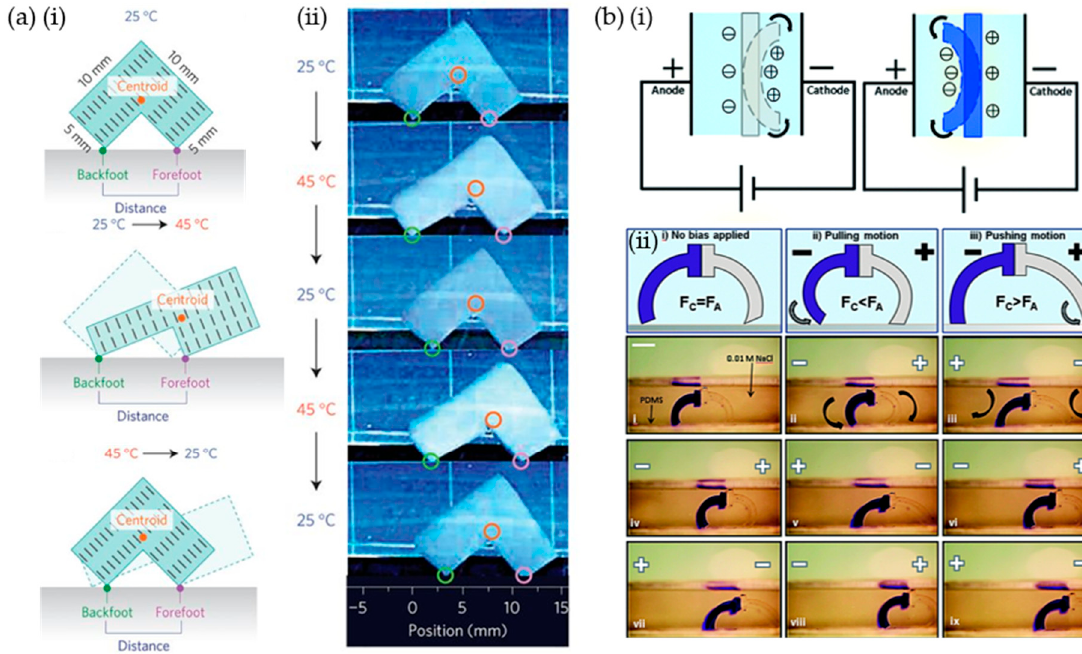
Figure 11. Actuation of hydrogel-based soft robots. ( a ) ( i ) Schematic of the ideal processing mechanism of anisotropic thermal expansion of a hydrogel-based soft robot (5 mm thick) from electrostatic repulsion of titanium nanosheet (TiNS) in dehydrated hydrogel, ( ii ) thermo-responsive actuation of an electrostatically anisotropic hydrogel soft robot. Alternate heating and cooling was conducted between 25 ◦ C and 45 ◦ C at a rate of 0.1 ◦ C / s. ( b ) ( i ) Scheme of the bending direction of electro-active materials; acrylamide (AAm) / sodium acrylated (NaAc) copolymer (light gray) and AAm / quaternized dimethylaminoethyl methacrylate (DMAEMA-Q) copolymer (blue), ( ii ) electro-actuated hydrogel walker in 0.01 M NaCl composed of 50% NaAc and 30% DMAEMA-Q legs and an applied field of 5 V / cm (scale bar: 5 mm). ( a ) Reproduced with permission [28]. Copyright 2015, Nature Publishing Group. ( b ) Reproduced with permission [40]. Copyright 2014, Royal Society of Chemical.